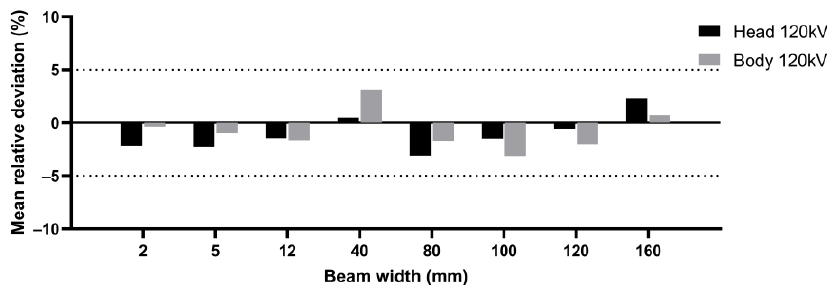
Figure 7. Relative deviation [ ∆ CTDI ] IVIscan at 120 kV for head and body phantoms over the largest ref beam width for ( a ) SN2 with N × T = 160 mm, ( b ) SN3 with N × T = 80, 100, 120 and 160 mm, ( c ) SN4 with N × T = 100, 120 and 160 mm.